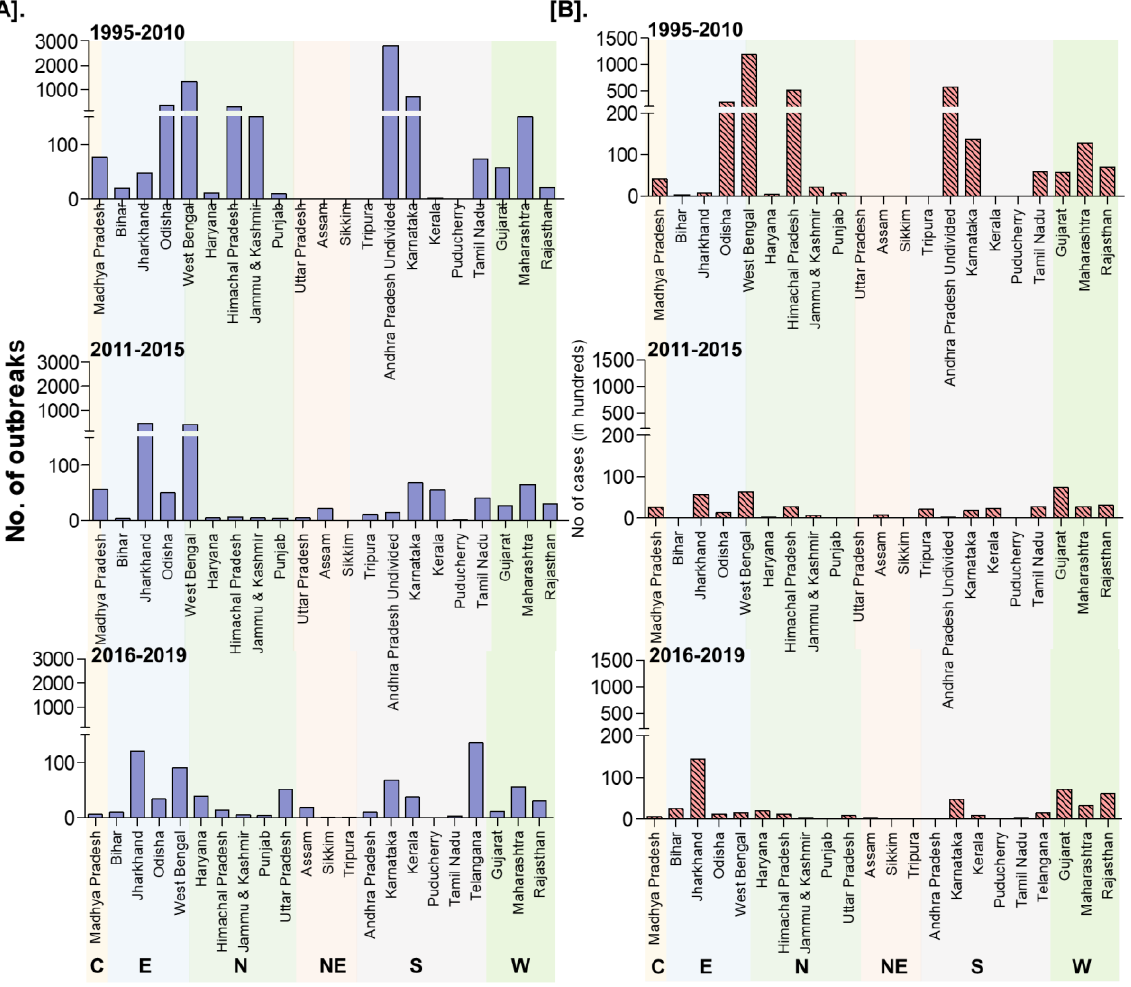
Figure 6. The state-wise occurrence of cumulative PPR reports in India (1995–2019). ( A ). Outbreaks ( B ). Cases. C-Central zone; E-East zone; N- North Zone; NE-North-East Zone; S-South Zone; W-West zone. Karnataka and Andhra Pradesh have shown a decline in the number of outbreaks during 2011-FS115 and 2016-19 with sporadic outbreaks in 2018 and 2019; West Bengal and Jharkhand states have reported the highest outbreaks during 2011–2015 and 2016–2019 periods, respectively.